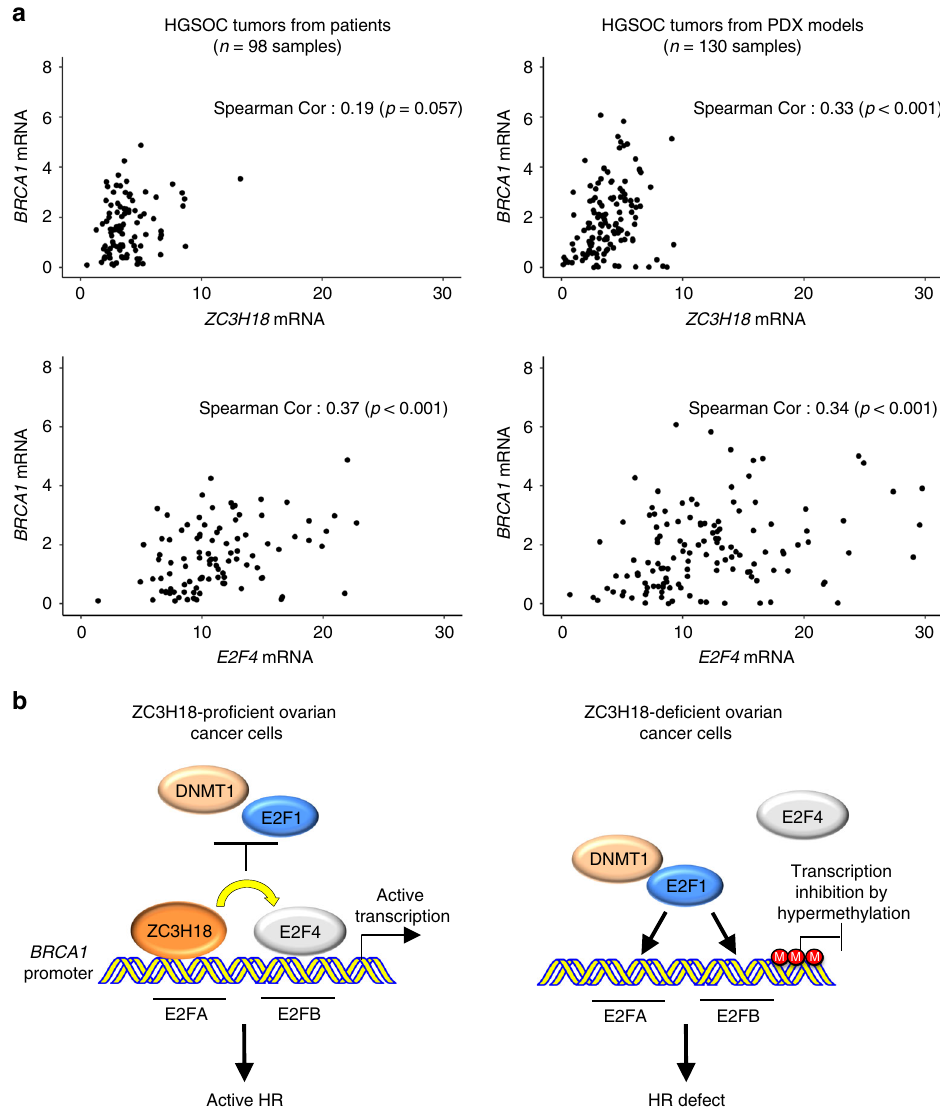
Fig. 7 ZC3H18 and E2F4 expression correlates with BRCA1 levels in HGSOC patient and PDX tumors. a Scatter plots of BRCA1 mRNA expression as a function of either ZC3H18 or E2F4 mRNA expression in HGSOC tumors from patients and PDX models. mRNA expression is in RPKM units. b Model for the role of ZC3H18 in BRCA1 transcription. Left panel: in ZC3H18-pro fi cient cells, ZC3H18 directly binds to the E2FA site on the BRCA1 promoter, where it promotes E2F4 occupancy at the E2FB site, thereby preventing E2F1-dependent DNMT1 occupancy and promoter methylation and inducing BRCA1 transcription. Right panel: in ZC3H18-de fi cient cells, E2F1 occupies both E2FA and E2FB sites and causes DNMT1 loading onto the promoter, leading to methylation of the promoter, reduced expression of BRCA1, and disruption of HR. Spearman correlations are shown in the Gray of ionizing radiation, incubated at 37 °C for 6h, fi xed with 3% paraf- ormaldehyde in phosphate buffered saline (PBS) for 12min, and permeabilized in 0.25% Triton X-100 in PBS for 10min. The slides were blocked with 3% bovine serum albumin in PBS containing 0.25% Triton X-100, incubated at room tem- perature overnight with rabbit polyclonal primary antibody to RAD51 (1:250, PC-130, Calbiochem) and mouse monoclonal antibody to phospho-histone H2A.X ( γ -H2A.X) (1:250, 05-636, Millipore), washed three times with PBS, incubated with anti-rabbit Alexa Fluor ® 488 and anti-mouse Alexa Fluor ® 594 – conjugated sec- ondary antibodies (1:500; ThermoFisher Scienti fi c) for 1 h in the dark, washed once with PBS, incubated with Hoechst-33342 (1:1000, ThermoFisher Scienti fi c) for 2min to stain the nuclei, mounted in Prolong Gold Antifade (ThermoFisher Scienti fi c), and examined with a confocal laser scanning microscope using a ×40 or ×100 objective. Immunoblotting . Two days after siRNA transfection, cells were harvested and lysed in 50 mM HEPES (pH 7.6), 150 mM NaCl, 1mM EDTA, 1% Triton X-100, 2, they were transfected with the same siRNAs as on day 1 along with 20 μ g pCßASceI plasmid (encoding I-SceI) with empty vector (pcDNA3) or expression